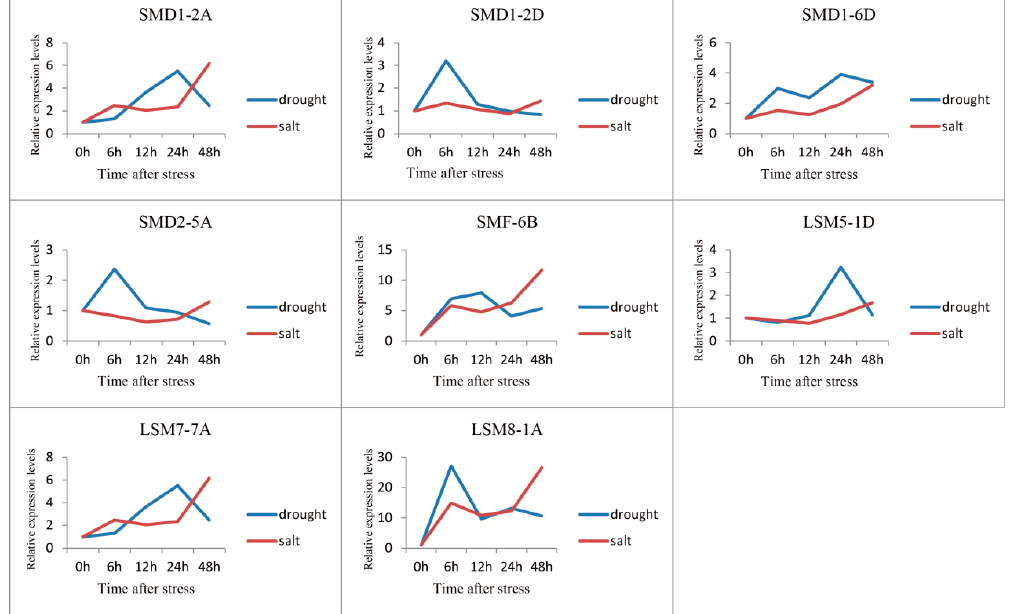
Figure 7. Real-time quantitative polymerase chain reaction (qRT-PCR) analysis of 8 TaSSM/SLSM genes. Expression levels of eight TaSSM/SLSM genes were analyzed using qPCR in the leaves. The pressure treatment was divided into 6, 12, 24, and 48 h, and the levels at 0 h are presented as the relative ratios. The experiments were repeated three times. The red line shows the gene expression under salt stress. The blue line shows the gene expression under drought stress.